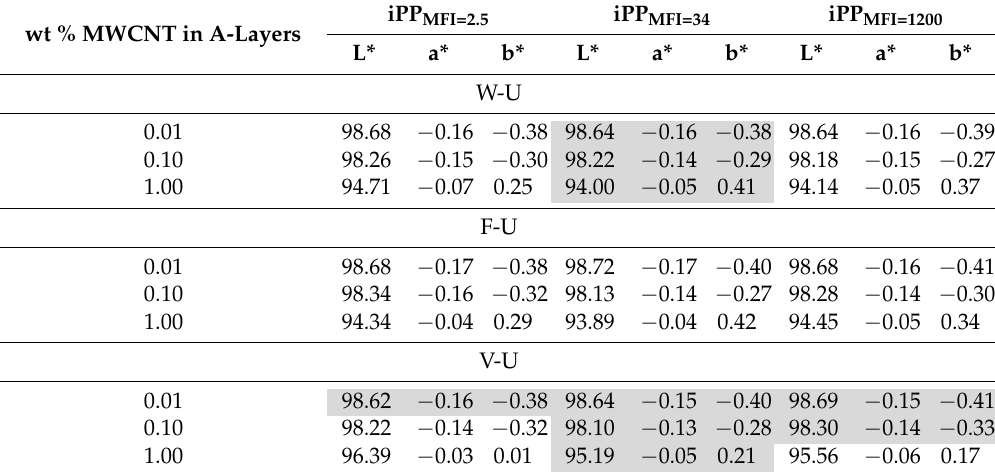
Table 4. Color coordinates L*, a*, and b* for ABA films fabricated using masterbatches with MFI = 2.5, 34 and 1200 g/10 min. The masterbatches were fabricated using ultrasound-assist methods: W-U, F-U and